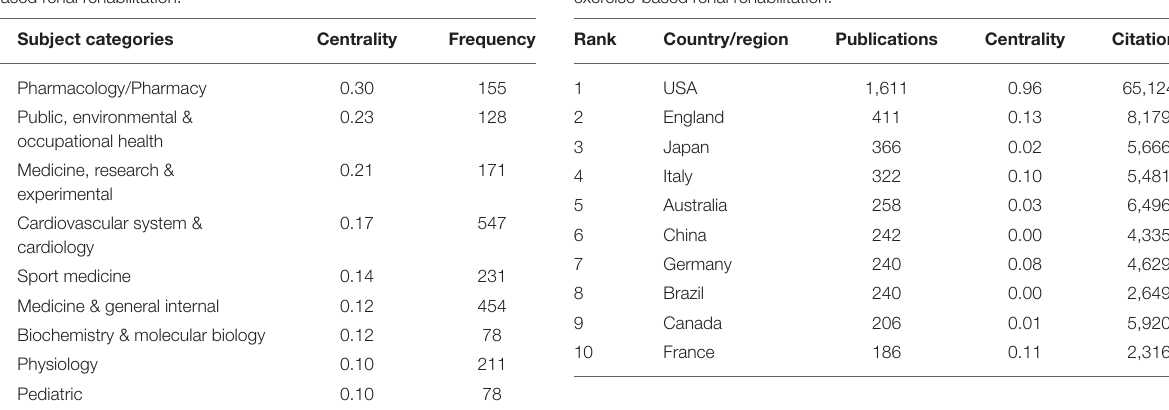
TABLE 2 | Top 10 countries/regions based on publications related to exercise-based renal